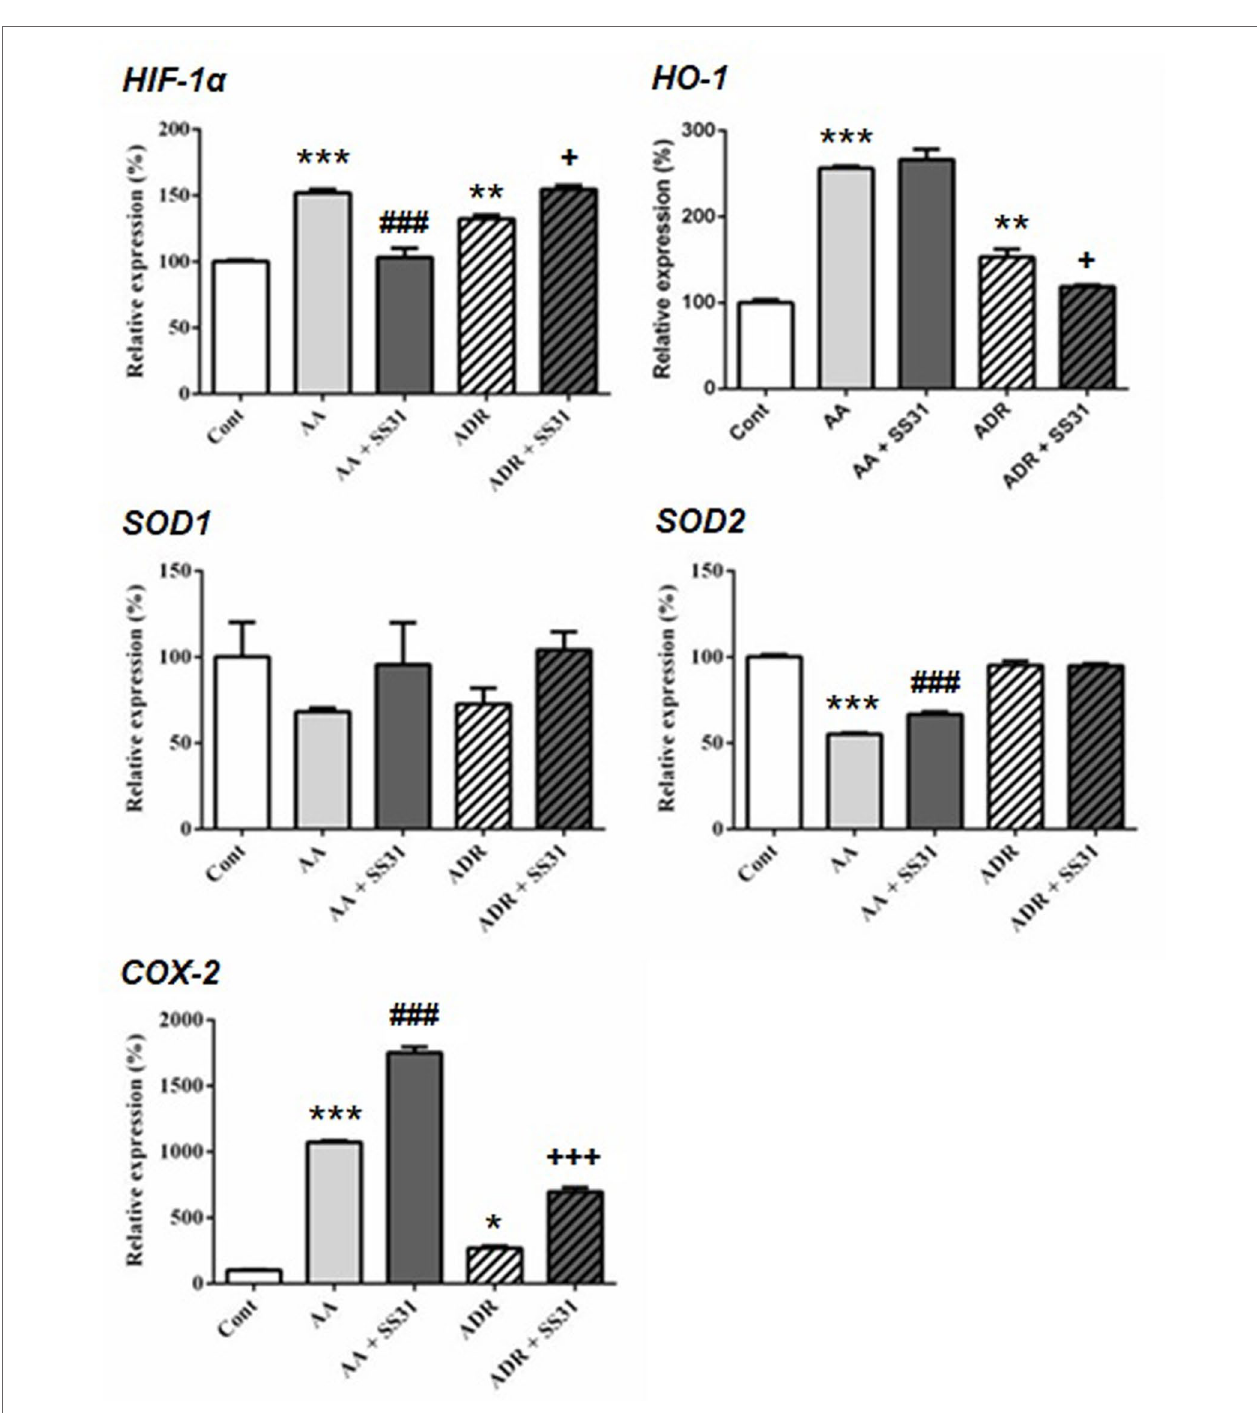
FIGURE 2 | Expression of the oxidative stress pathway-responsive genes in the kidneys of mice exposed to aristolochic acid or adriamycin, without or with SS-31. Acute renal injury was induced by i.p. injection of aristolochic acid (AA) or adriamycin (ADR) in 10 weeks old BALB/c male mice (n = 5 mice per experimental group), without or with the administration of SS-31 (AA + SS31 or ADR + SS31). At the end of the experiment (day 7), the animals were sacrificed and mRNAs were extracted from the snap-frozen kidneys. Healthy wild-type BALB/c male mice were used as controls (Cont). The levels of expression of the mRNAs for hypoxia inducible factor1- α (HIF-1 α ), heme oxygenase-1 (HO-1), superoxide dismutase-1 (SOD1), SOD2 and cyclooxygenase-2 (COX-2) were quantified by qRT-PCR. Results were averaged for all animals in each experimental group and are presented as % of changes in the mRNA levels in the treated animals versus control animals ± sem. *: AA or ADR compared to Cont; # : AA + SS-31 or + : ADR + SS-31 compared to AA or ADR alone, respectively. (*p < 0.05; **p < 0.01; ***p < 0.001; applies to all